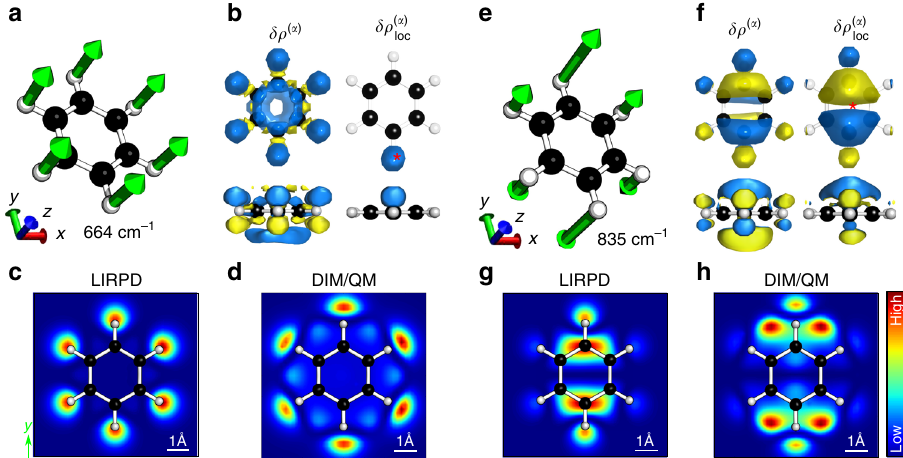
Fig. 2 Normal modes, Raman polarizability densities, and TERS images of benzene. Normal modes a – d at 664 cm − 1 and e – h at 835 cm − 1 . a , e Schematic representation of molecular vibrations. b , f Raman polarizability density (left column) and locally enhanced Raman polarizability density (right column) by a near fi eld at the marked position (red asterisk) from the top view (top) and side view (bottom). The density is normalized and the absolute isovalue is set to 0.2 with the positive sign in blue and the negative sign in yellow. Simulated TERS images obtained by LIRPD in c , g , and the hybrid atomistic DIM/QM in d , h ,